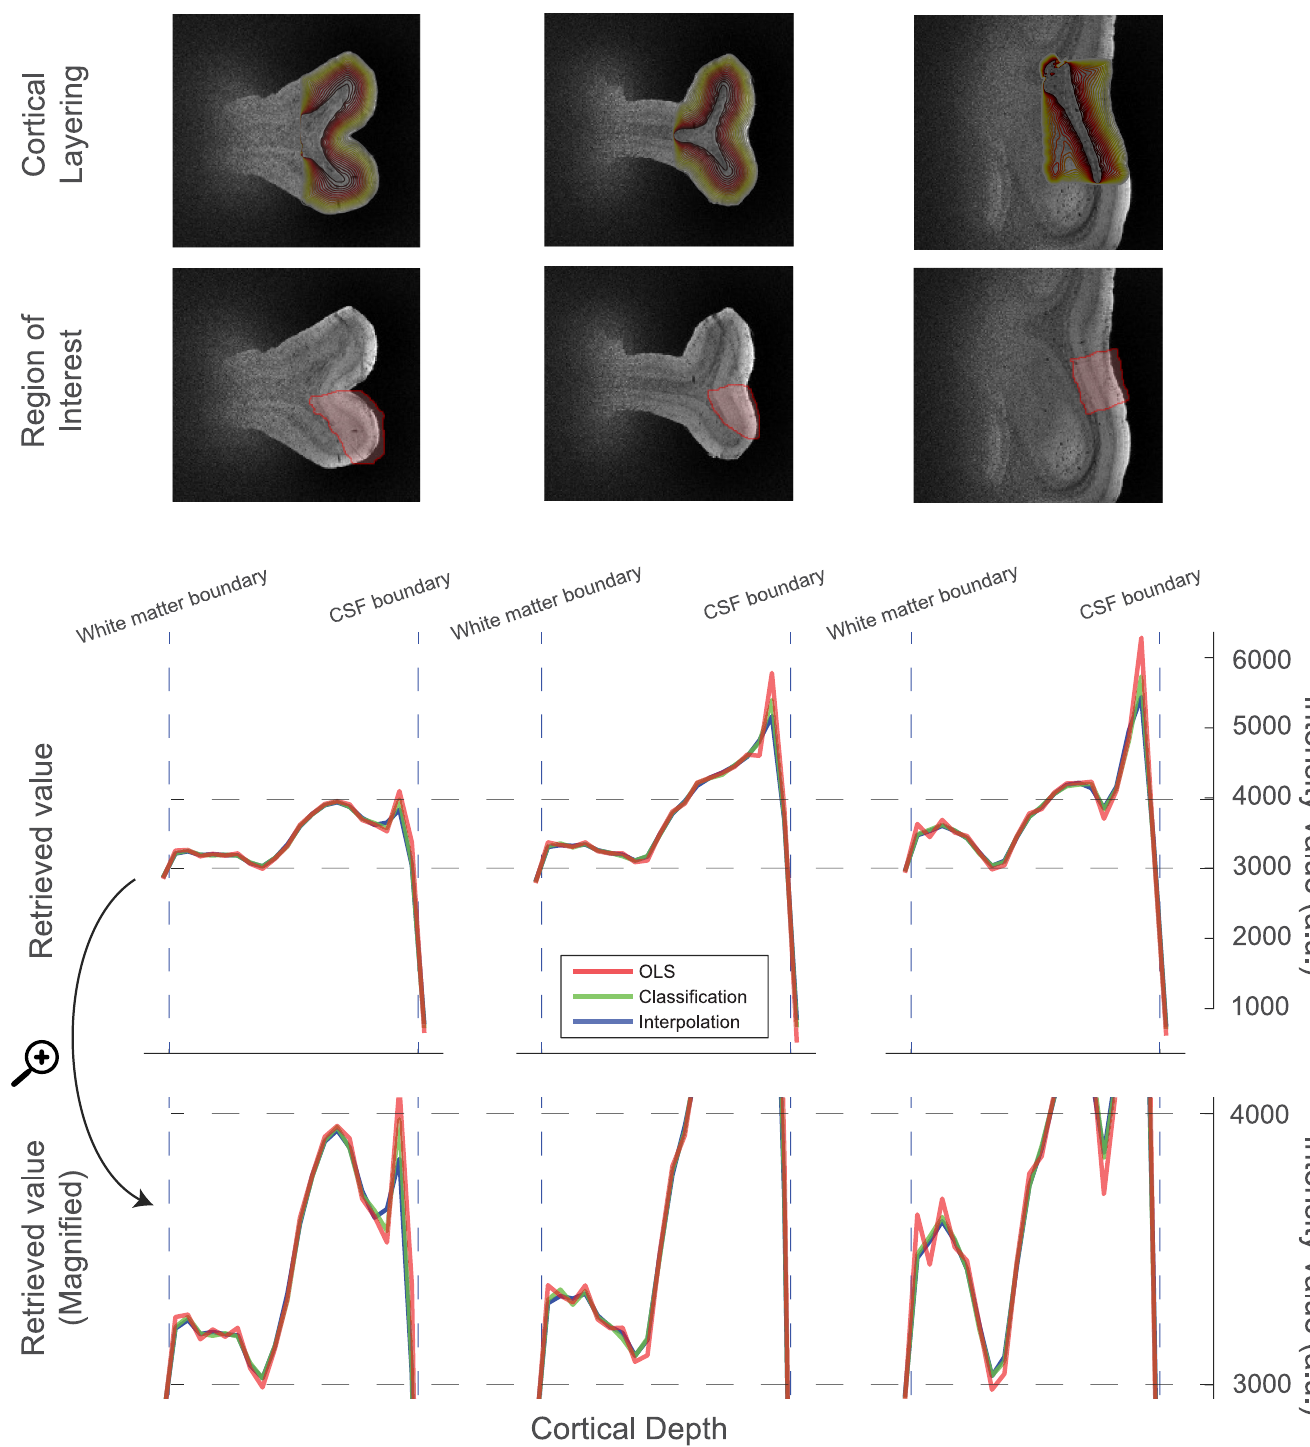
Fig 6. The layering, the regions of interest, and the extracted cortical profiles for three regions. While all three methods perform almost identically, there are small oscillations present in the profiles as produced by the GLM. Especially in the top layer, the peak is potentially mistakenly higher than both other methods suggest.